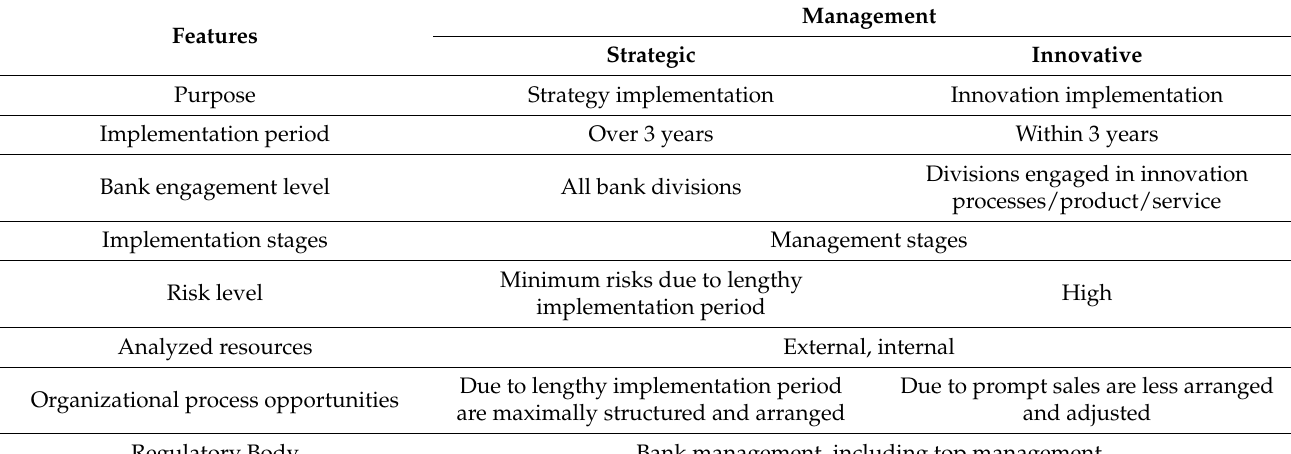
Table 1. Comparison of strategic and innovative management in commercial